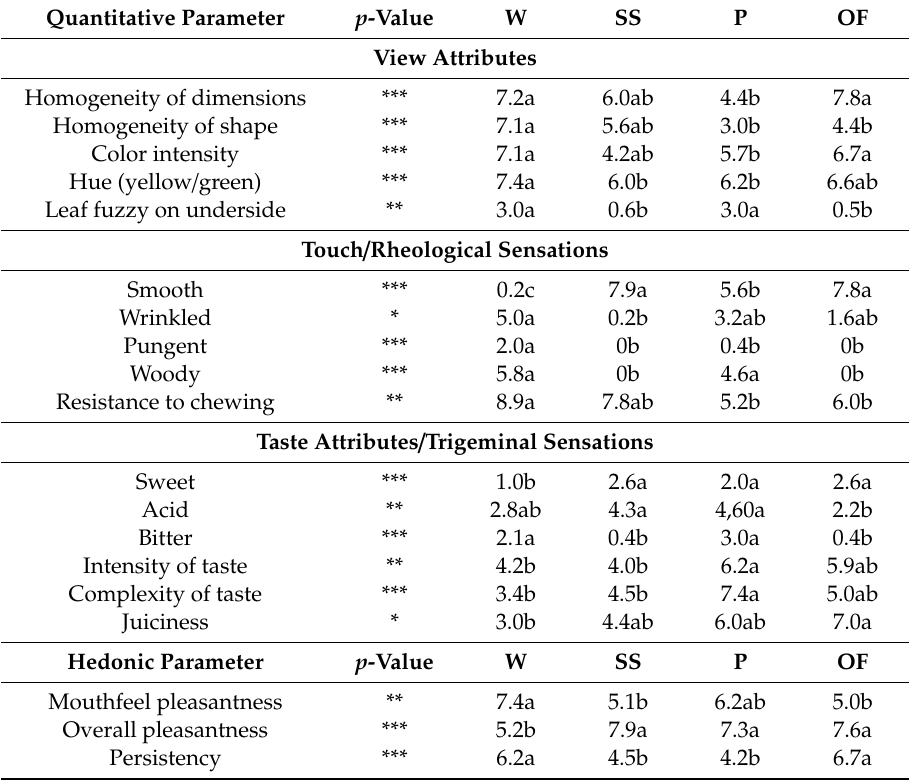
Table 5. Two-way ANOVA calculated for all quantitative and hedonic parameters evaluated by panelists during tasting sessions for Plantago coronopus . Only data that showed significant di ff erences ( p < 0.05) are reported. Means keyed with a di ff erent letter are significantly di ff erent for p = 0.05, considering each species independently and following one-way ANOVA, with wild-collection or the di ff erent domestications as the variability factor. Significance level: ***: p < 0.001 (F = 7.94); **: p < 0.01 (F = 4.77); *: p < 0.05 (F = 3.01).